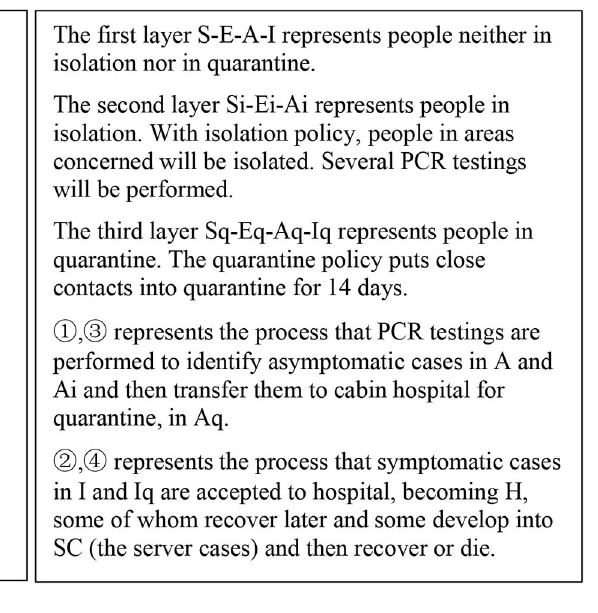
FIGURE1 The structure of Shanghai Omicron epidemic